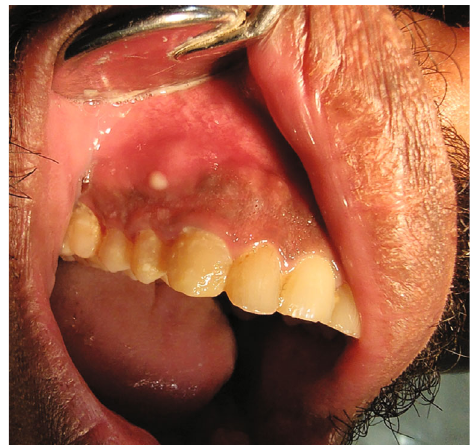
Figure 5: Clinical picture of case 2 showing yellowish pus discharge apical to the maxillary 1 st premolar.